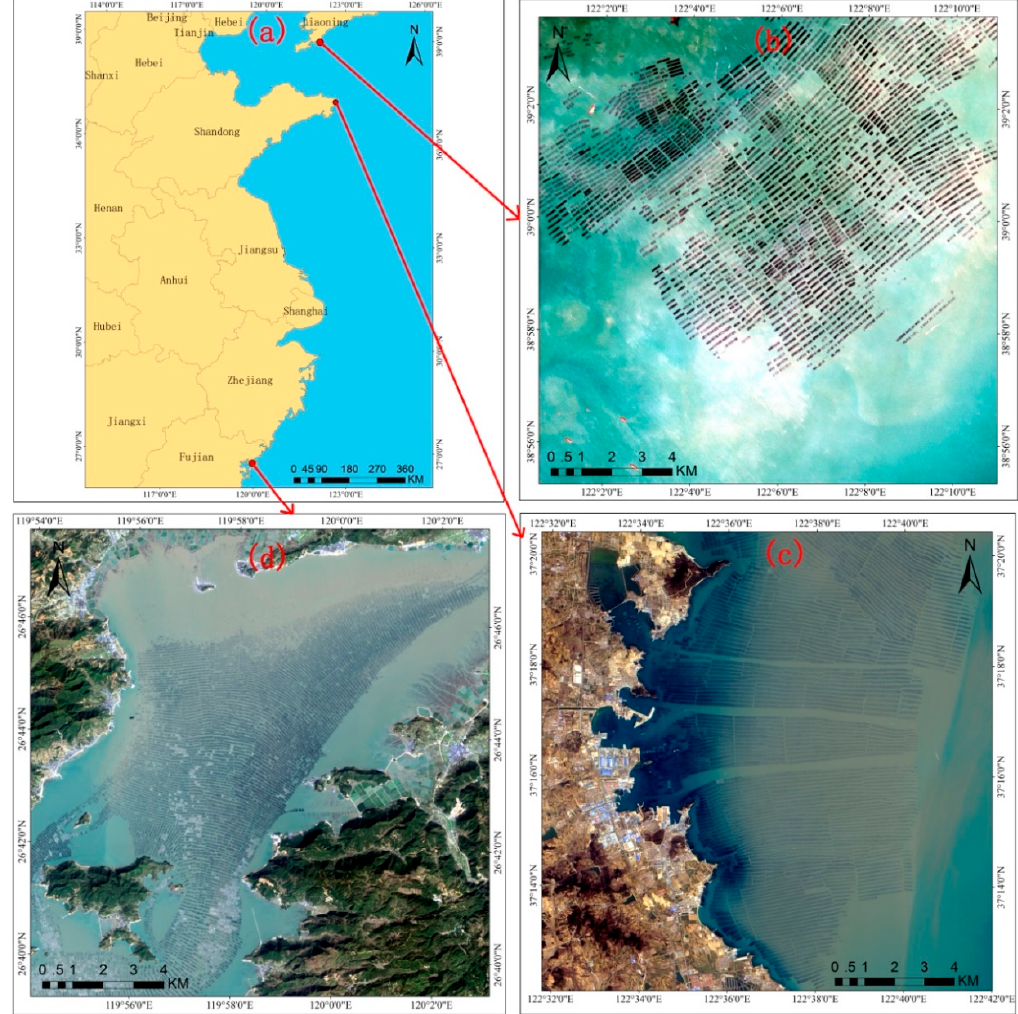
Figure 3. Map of ( a ) coverage of the experimental area and aerial photographs of study areas ( b ) 1, ( c ) 2, and ( d ) 3. Table 1. Introduction to the experimental areas.